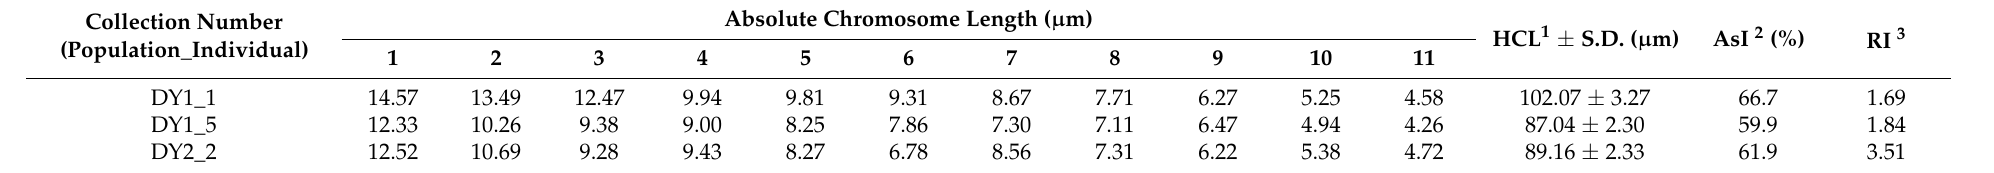
Table 3. Karyotype analyses in the Korean endangered species, Cypripedium japonicum